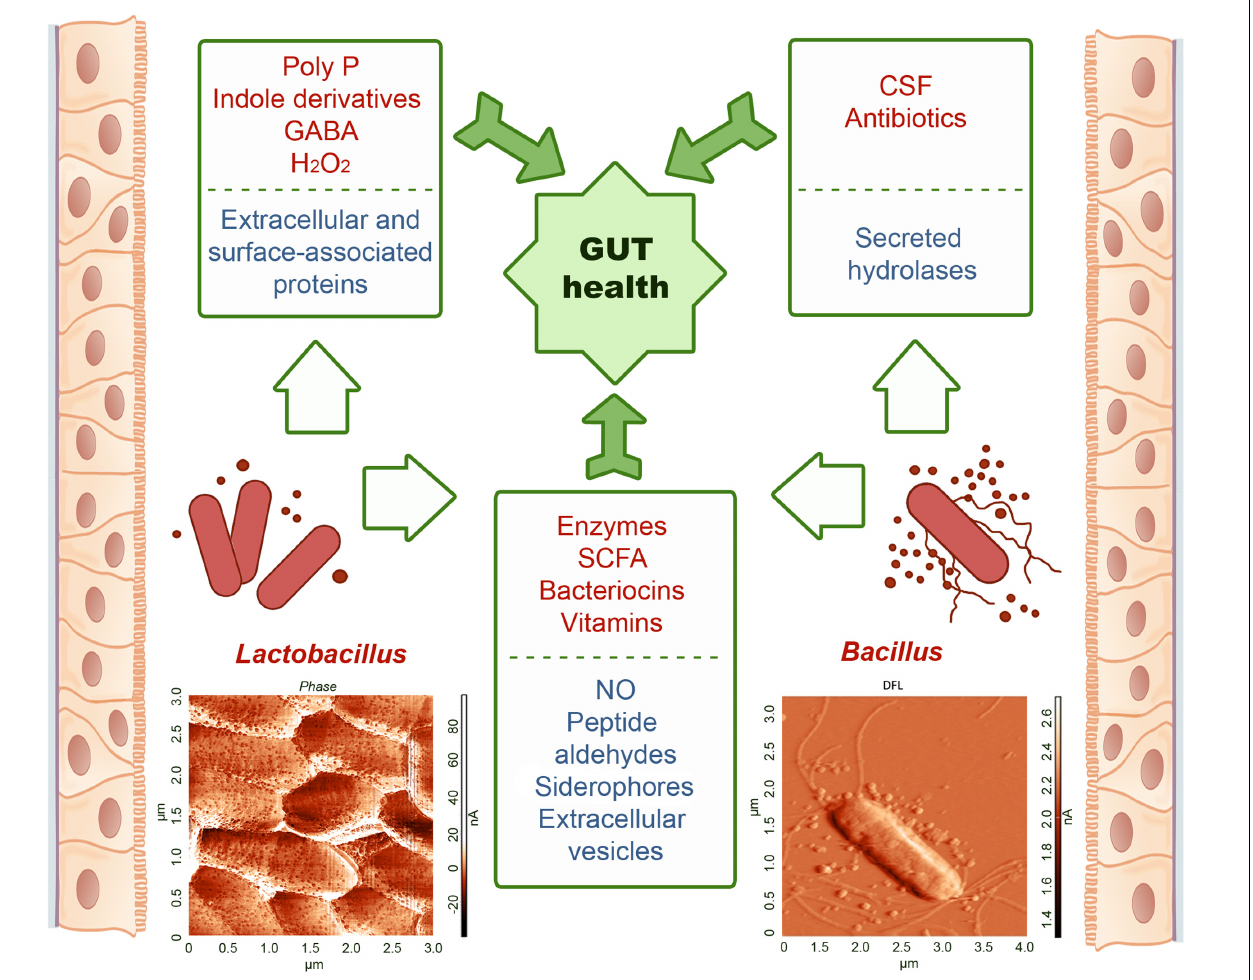
FIGURE 1 | Compounds secreted by the representatives of Lactobacillus and Bacillus mediating their beneficial effects in the GIT. Top-appreciated compounds are shown in upper part of panels, under-appreciated compounds – in lower parts. Both Lactobacillus and Bacillus are minor part of GIT microbiota. Of them, Lactobacillus spp. dominate quantitatively secreting a few compounds, while Bacillus spp. are less abundant but produce a variety of secreted substances with a wide spectrum of activities. Representatives of the Bacilli class were isolated from colon epithelia biopsy of the patients with diagnosed colorectal cancer. Atomic force microscopy images of L. plantarum (photo provided by Dr. Dina Yarullina ) and B. pumilus (photo kindly provided by Dr. Galina Yakovleva ) were obtained in air (contact mode) of stationary phase cells that were deposited on glass and dried prior analysis. Bacteria were identified using MALDI-TOF technique and 16S RNA sequencing. Representative AFM images show nanoscale structures on the cell surface and around the cells attributed to